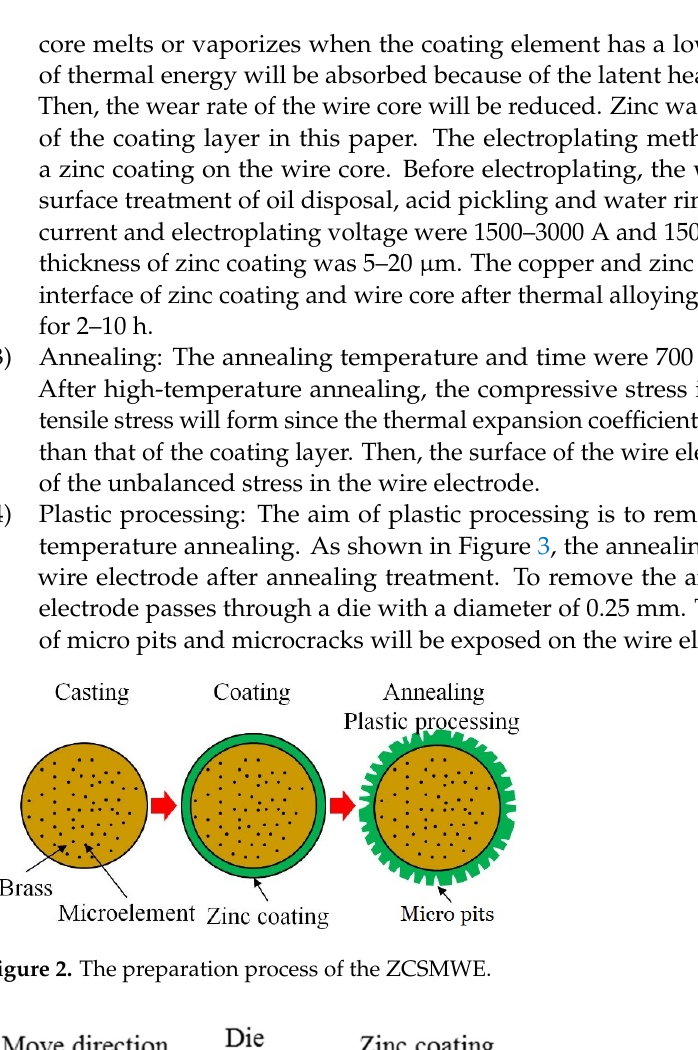
( b ) Figure 4. The cross section and surface topography of ZCSMWE: ( a ) Cross section; ( b ) Surface to ‐ pography. Table 4 displays the EDS results of the wire core and the surface of ZCSMWE. It is observed that the content of the copper element within the wire core of the ZCSMWE is relatively high, while Zn is relatively low, being 13.7% and 21.6%, respectively, which corresponds to the above introduction. After the tensile test, Young’s modulus of the ZCSMWE was 310 MPa, and BWE was 280 MPa, indicating that the ZCSMWE is less prone to rupture than BWE. Table 4. EDS chemical composition of the core and the surface of the ZCSMWE. Region